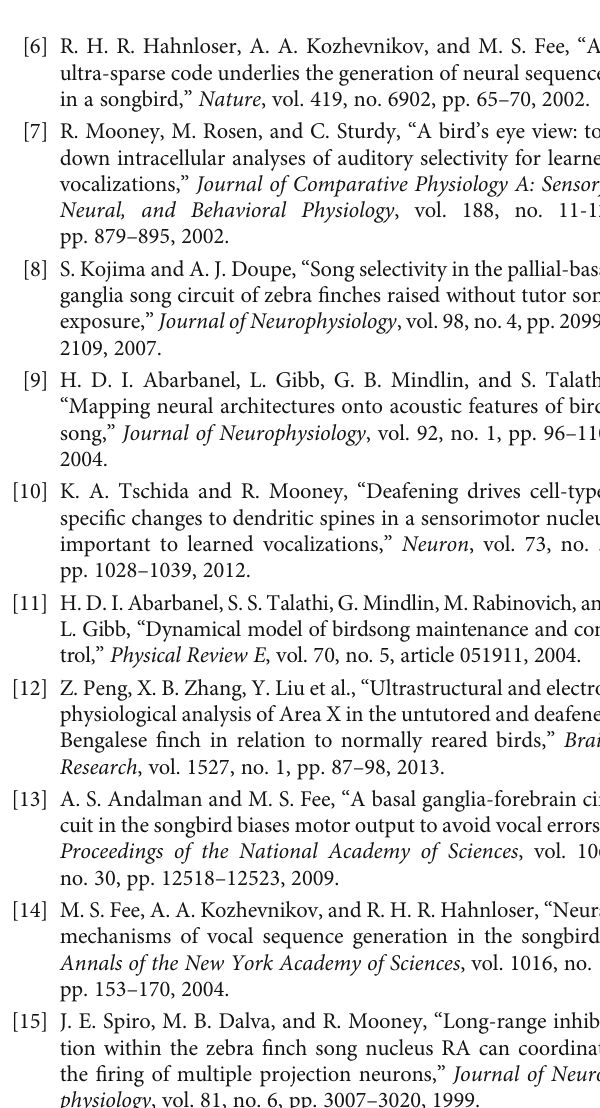
Figure 15: AFP ’ s adjustment amount (a) and rate (b) for each trial during song learning and DAF. They have two phases: normal phases where the adjustment decreases with an increasing number of trials and abnormal phases where the adjustment remains stable or even